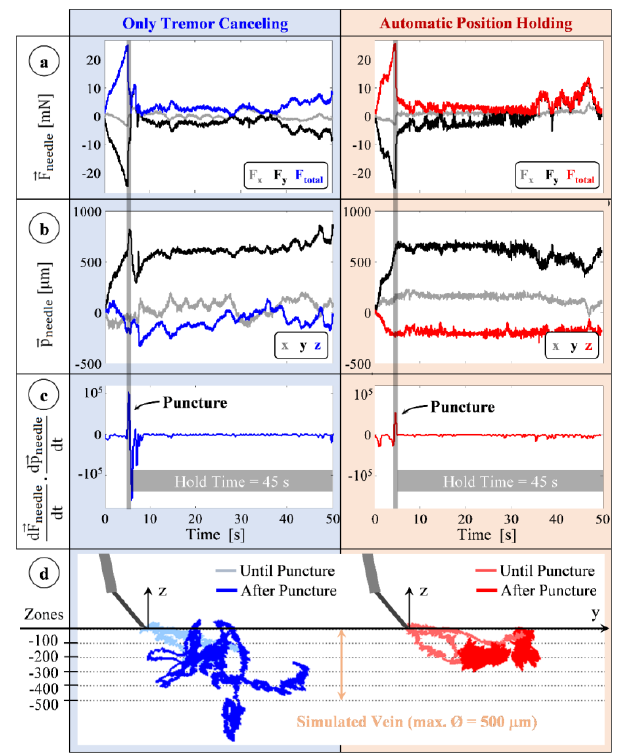
Figure 11. Typical measurements taken during trials of the first user using the tremor canceling (blue) and automatic position holding (red) features of the system. ( a ) Forces on the needle: mostly along the y-axis with a gradual rise during insertion and a sharp drop at the instant of puncture; ( b ) Position of the needle remains fixed with the position holding mode in contrast to the fluctuations with only tremor canceling; ( c ) The event of puncture: a positive peak in the inner product of needle velocity and force variation vectors; ( d ) Recorded needle tip trajectories for three representative trials of each mode. Position holding mode significantly reduced tool tip deviation from the puncture point [62].